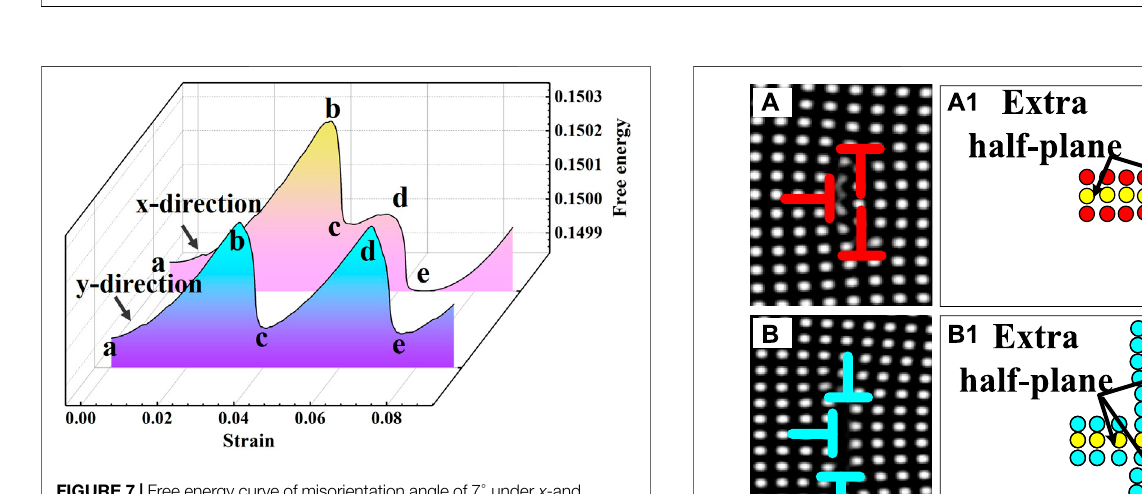
GBMs of 6 ° , both dislocation pairs and single edge dislocations exist and the dislocations arrangement is chaotic, as shown in Figure 4C1 . Four sub-grain boundaries appear in Figure 4B when the strain increases to 0.06. The existence of dislocation pairs reduces the lattice distortion energy and makes the sub- grain boundaries more stable. The dislocations are arranged in a “ double bowknot ” structure. Subsequently, annihilation occurs